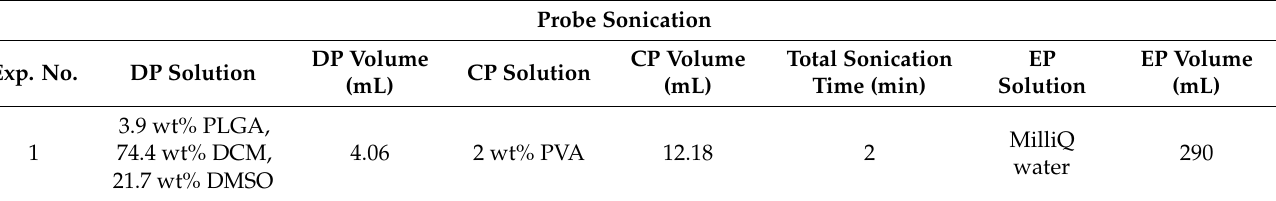
Table 1. Process parameters for the classic probe sonication